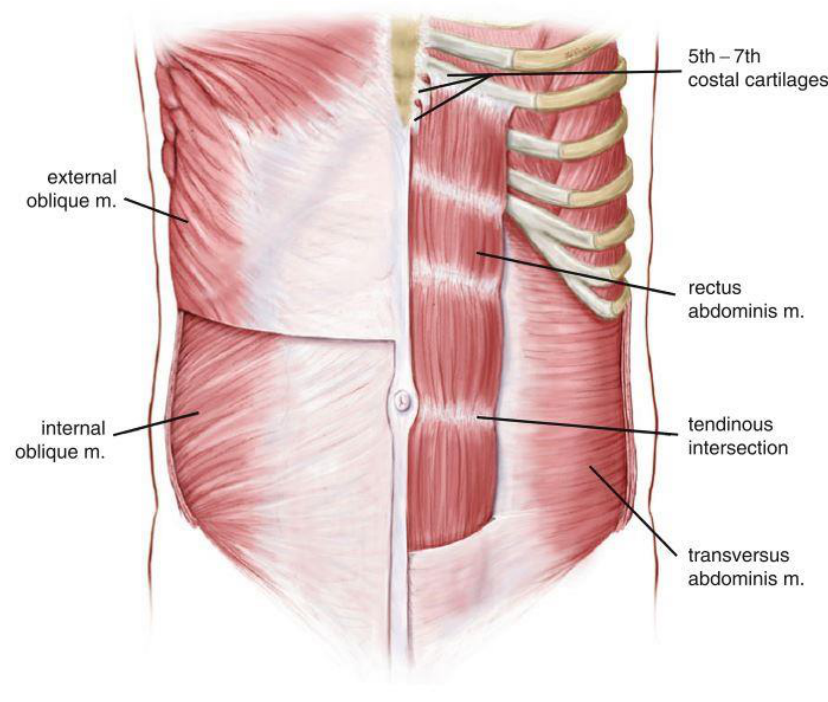
Figure 3. Anatomy of abdominal muscles [2].